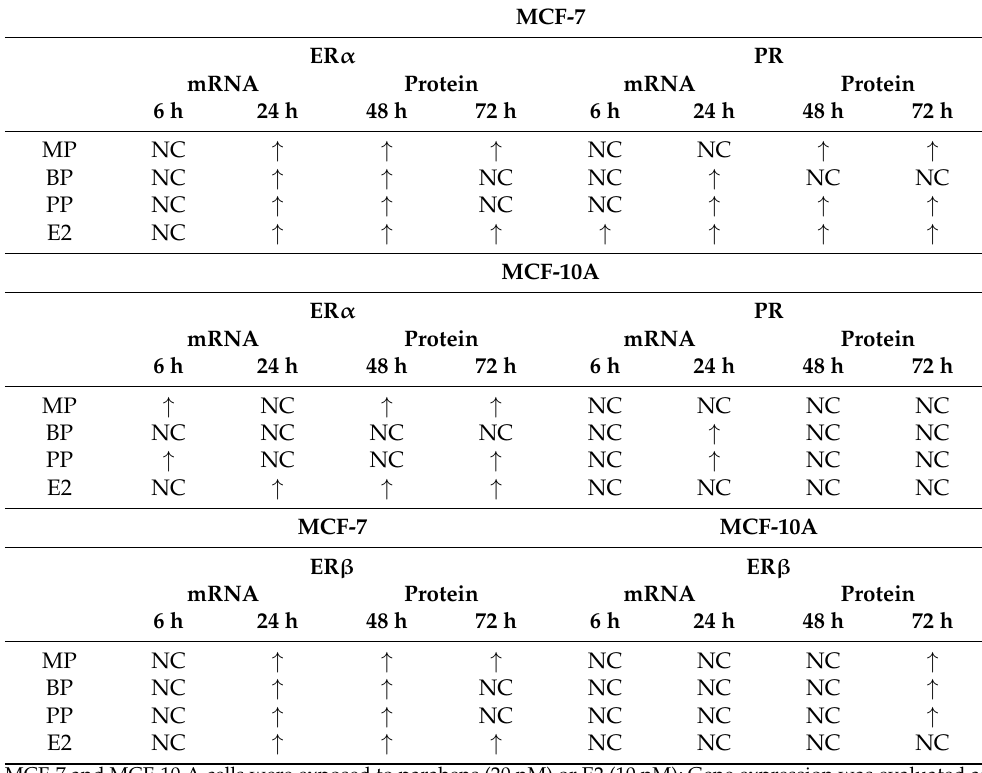
Table 2. Effect of 17 β -estradiol (E2) and Parabens on Estrogen and Progesterone Receptors Gene and Protein Expression [52].